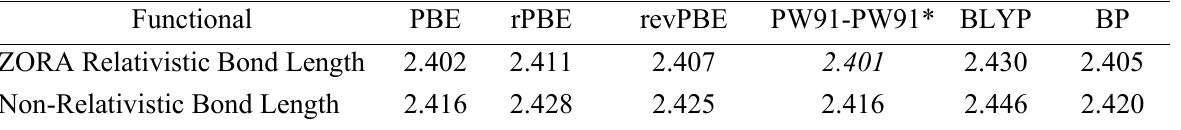
Table 2 . Rh-Rh bond lengths (Å) using ADF.